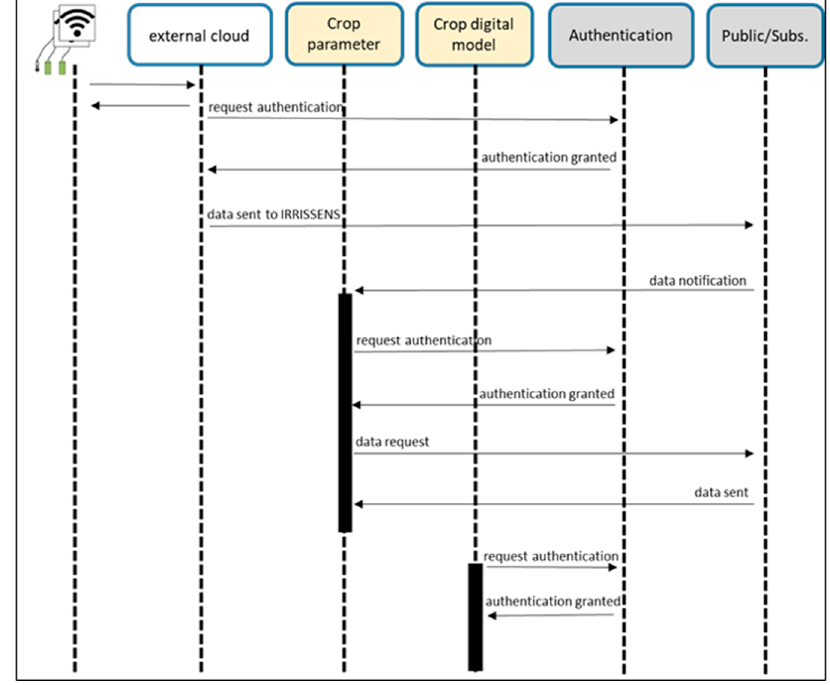
Figure 5. Mechanisms of authentication among all elements of IRRISENS.